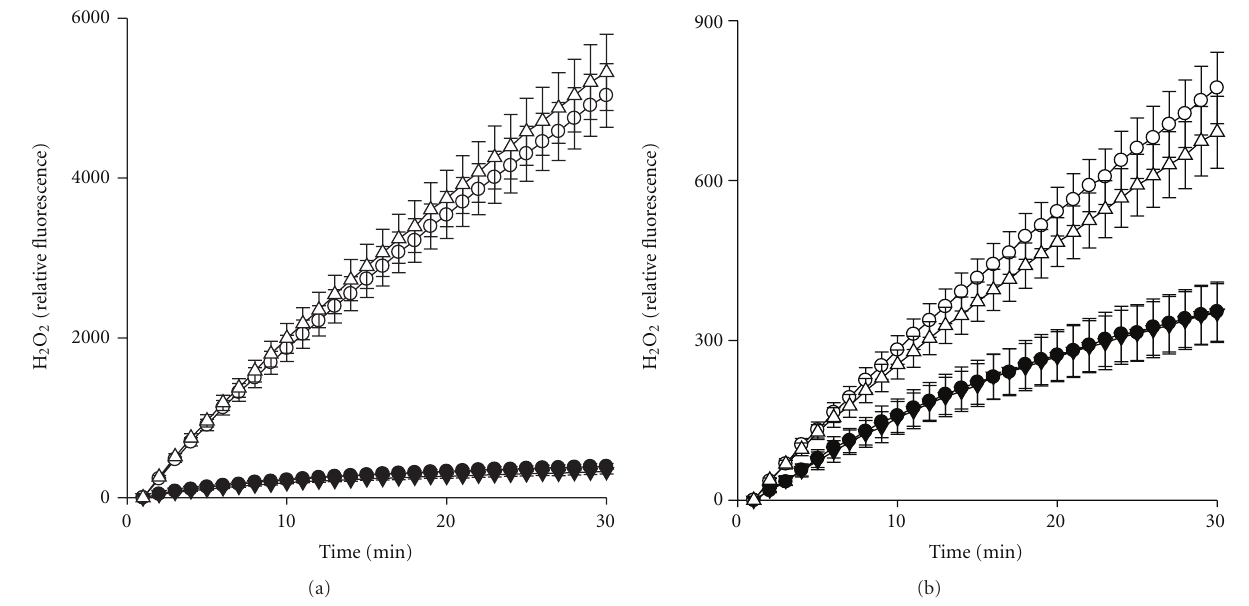
Figure 3: 1,25 vit D 3 does not suppress PMA-induced H 2 O 2 generation in adult or neonatal neutrophils. Adult (a) and neonatal (b) neutrophils (5 × 10 4 cells) were incubated with Amplex Red (25 μ M) and horseradish peroxidise and then treated with PMA (500nM) or medium control, in the presence or absence of 1,25-vit D 3 (10 − 7 M). H 2 O 2 production was quantified at 1min intervals for 30min. Each point represents the mean ± SE ( n = 6). Control, (cid:2) ; PMA, (cid:5) ; 1,25-Vit D 3 , (cid:2) ; PMA + 1,25-Vit D 3 , (cid:3)